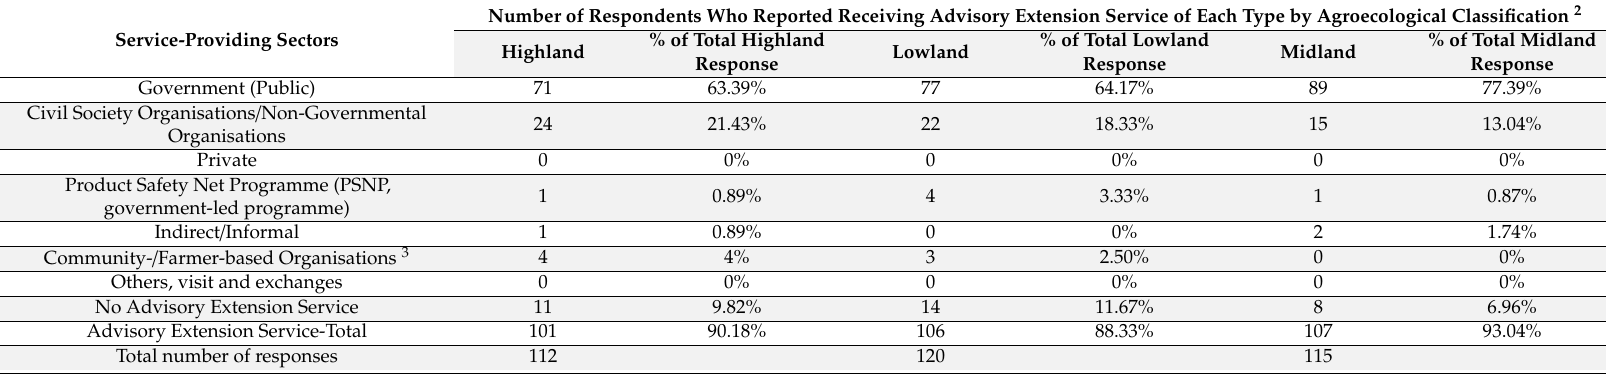
Table 4. Types of Advisory Extension Service received 1 by Smallholder Farmers (Questionnaire Survey). Responses categorised by Agroecological classification 2